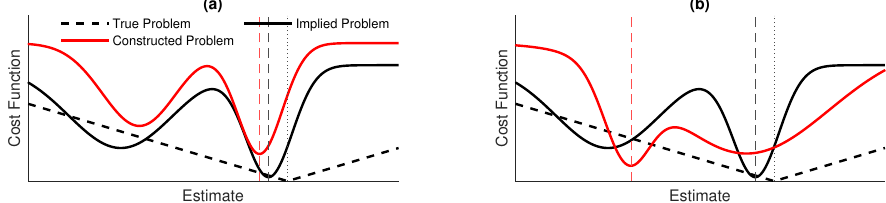
Figure 9. A simplified illustration of the cost functions considered in this work: in this example, the aim would be to find the estimate which minimizes the cost function. The quality of a cost function is measured by how close its minimum is to the minimum of the true problem, which would correspond to the correct estimate. However, this is not possible directly. The implied problem is to find a trajectory estimate which is consistent with respect to measurements. This is not done directly and, instead, a cost function is defined, creating the constructed problem using the functions defined in Section 3.3. Shown are ( a ) A constructed problem which matches well with the implied problem and ( b ) a bad constructed